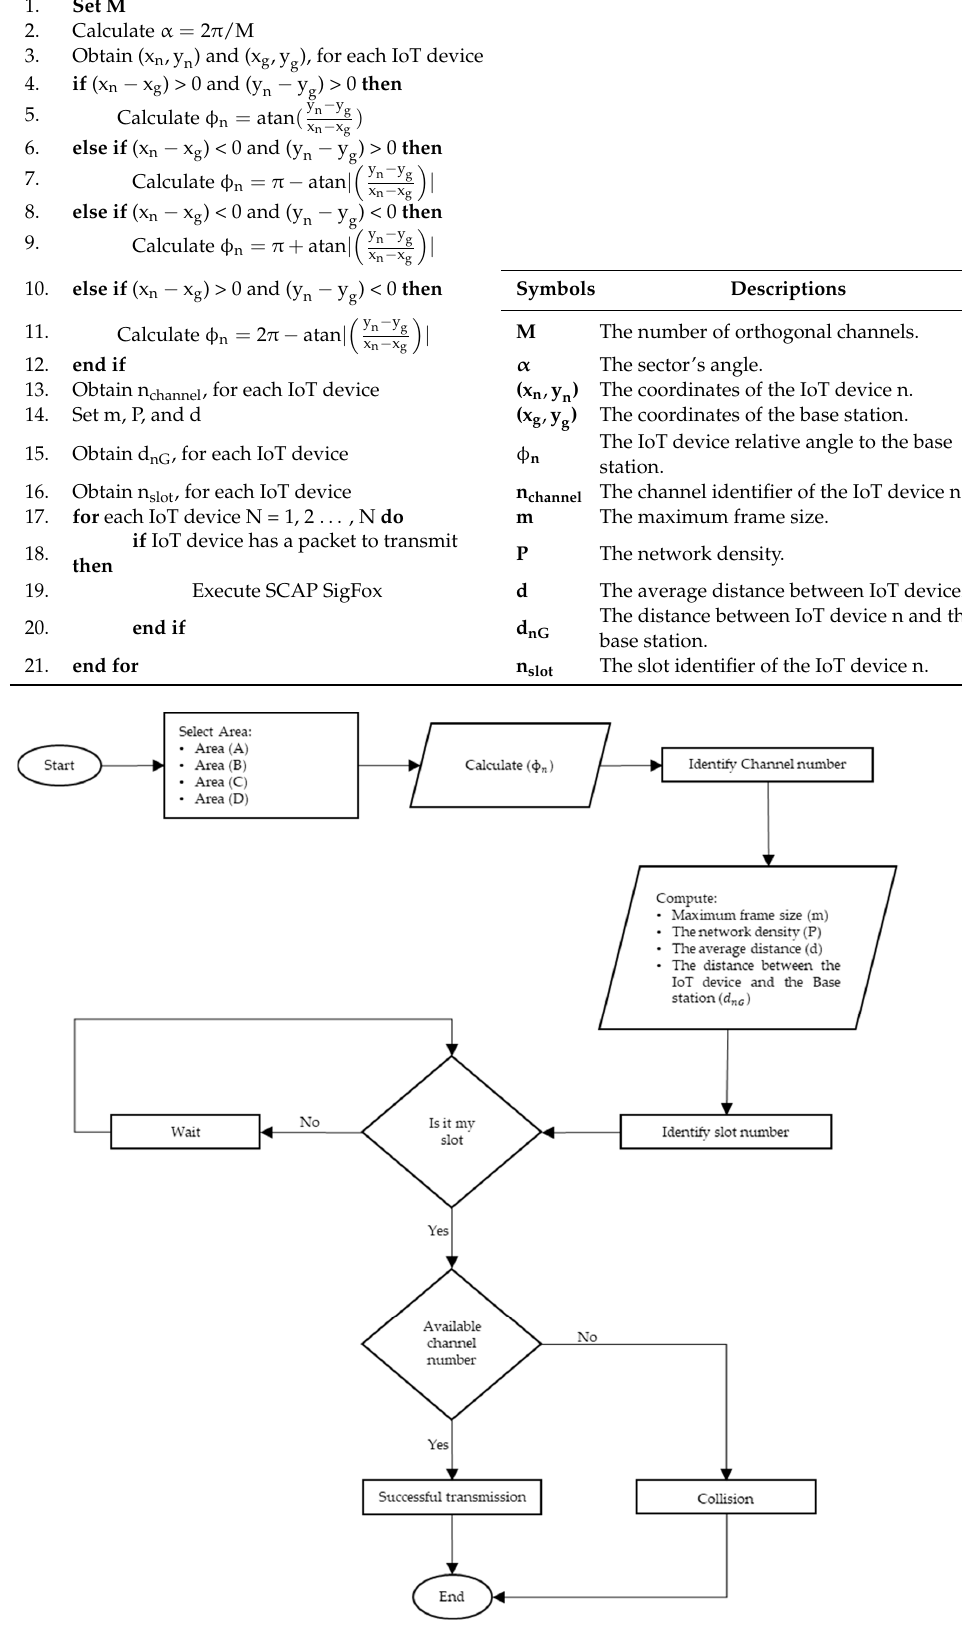
Figure 6. The work fl ow of the slot- and channel-allocation protocol (SCAP). Figure 6. The workflow of the slot- and channel-allocation protocol